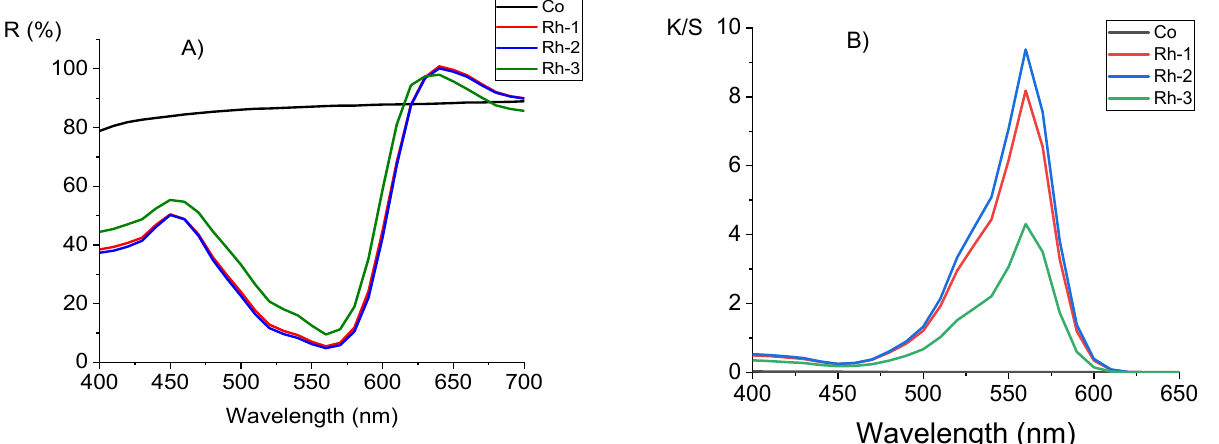
Figure 10. Comparison of cotton fabric (Co) and fabrics dyed with Rh-1, Rh-2, and Rh-3: ( A ) reflection spectra; ( B ) K/S values in function of wavelength.